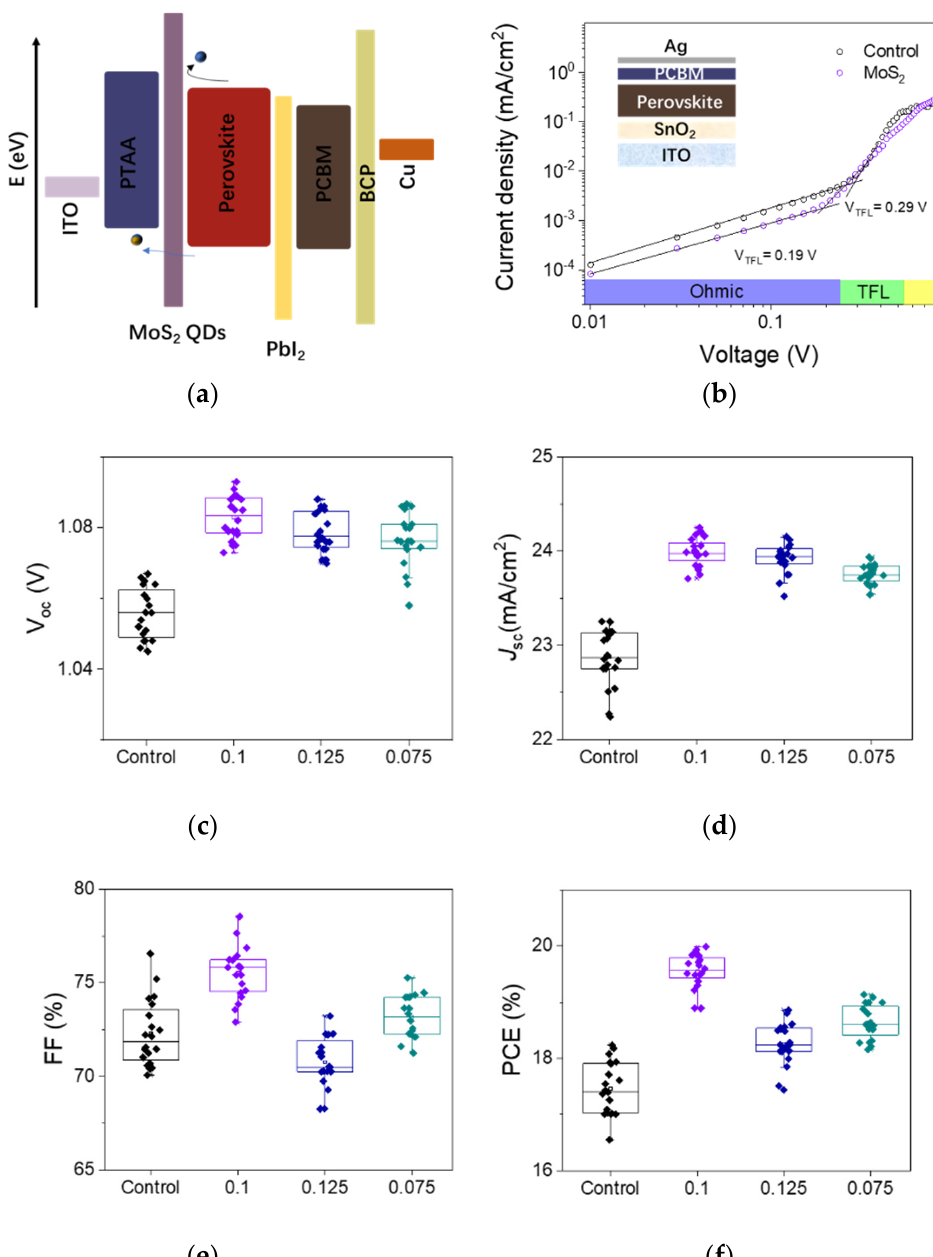
Figure 9. ( a ) Schematic diagram of band energy. ( b ) SCLC measurement of control device and device treated with MoS 2 . Inset: the electron-only devices structure diagram. ( c – f ) The statistics of V oc , J sc , FF, and PCEs of 20 devices for each fabrication